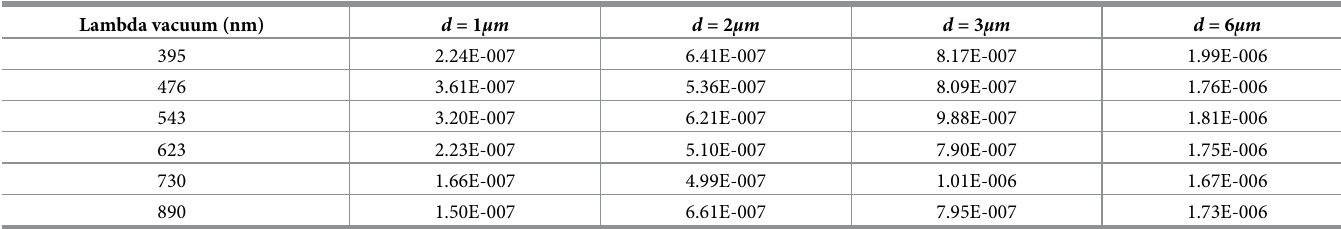
Table 1. C ¼ 2 d as a function of wavelength and microsphere diameter. 3 Q sca Lambda vacuum